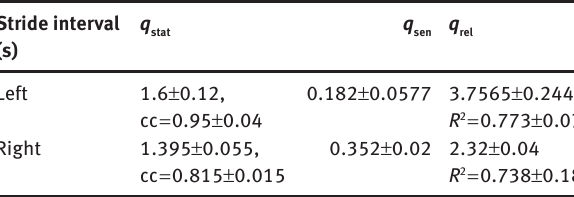
Table 2: Tsallis q -triplet for stride intervals corresponding to a subject with Parkinson’s disease (PD).